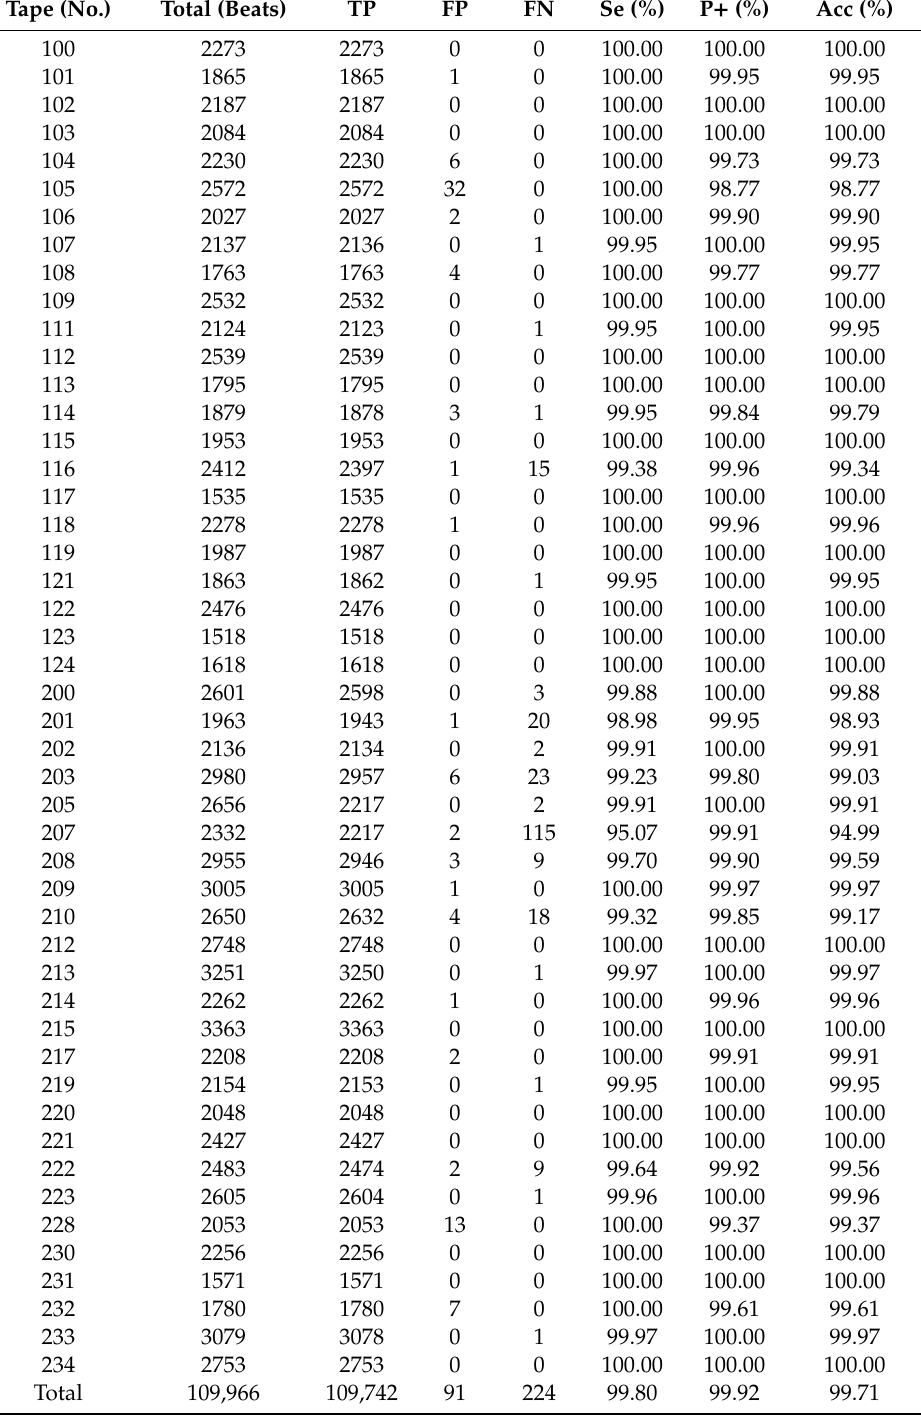
Table 2. Results of evaluating the proposed QRS-complex detection algorithm using MIT-BIH arrhythmia